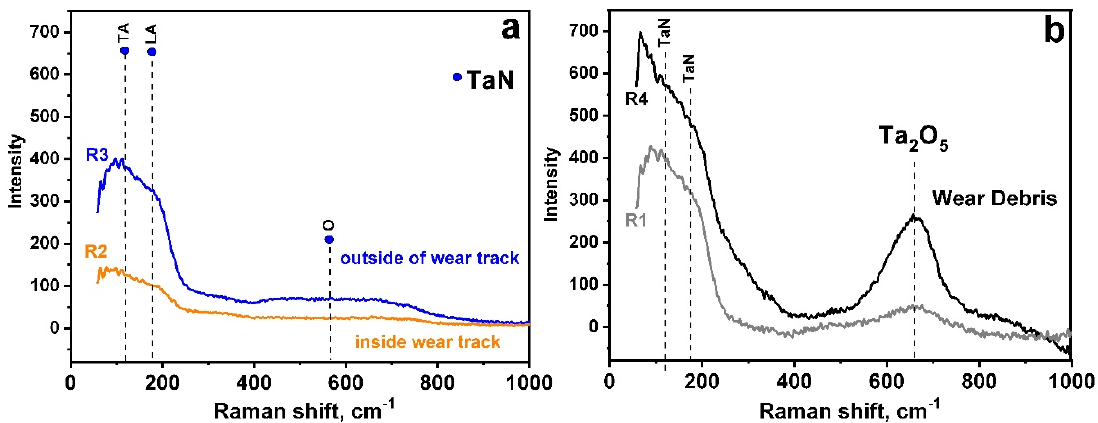
Figure 10. ( a ) Raman spectra of the Hier-TaN / Ta surface inside and outside of the wear track; ( b ) spectra of the wear debris generated after the macro-tribology tests; see Figure 9.